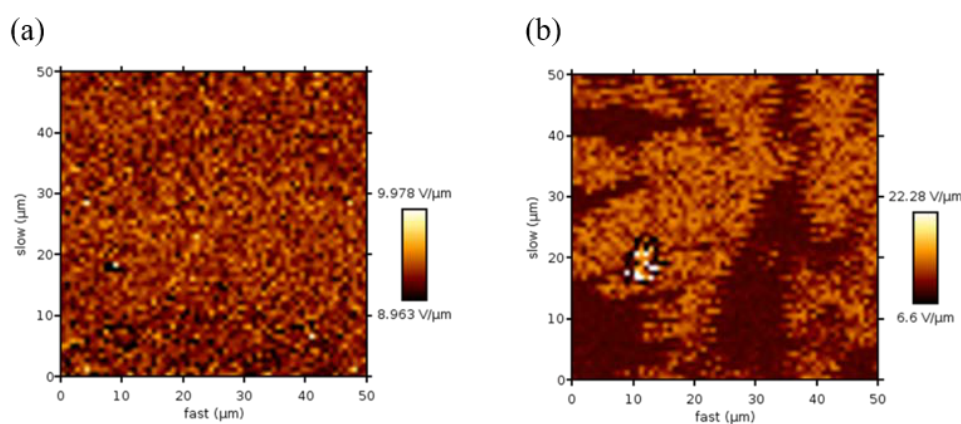
Figure 5. Topographic AFM images showing the adhesion scan normalised by the surface profile of ( a ) pristine PEDOT:PSS and ( b ) PEDOT:PSS films containing 1.40 wt% Tween 80.